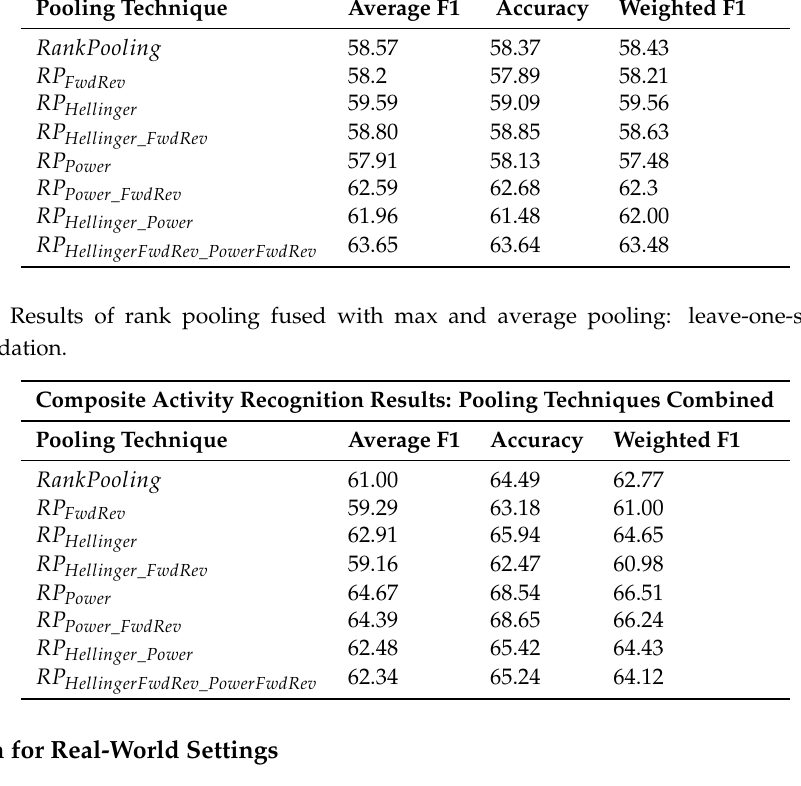
Table 5. Results of rank pooling fused with max and average pooling: hold-out setting. Composite Activity Recognition Results: Pooling Techniques Combined